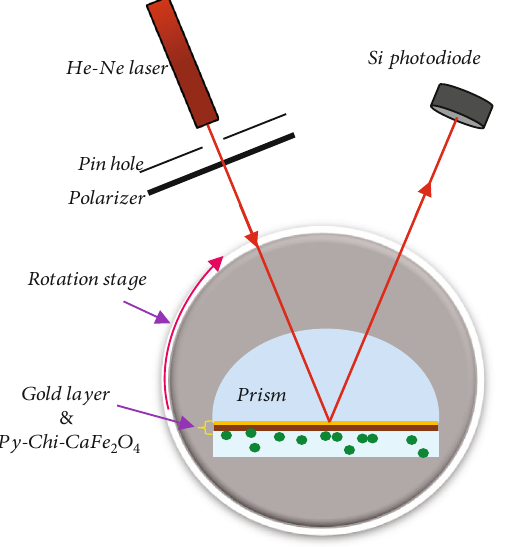
Figure 1: SPR setup contains a high index prism, a He-Ne laser (632.8 nm, model: R30990, Newport), a pinhole, a chopper, a polarizer, and a silicon photodetector [34 –